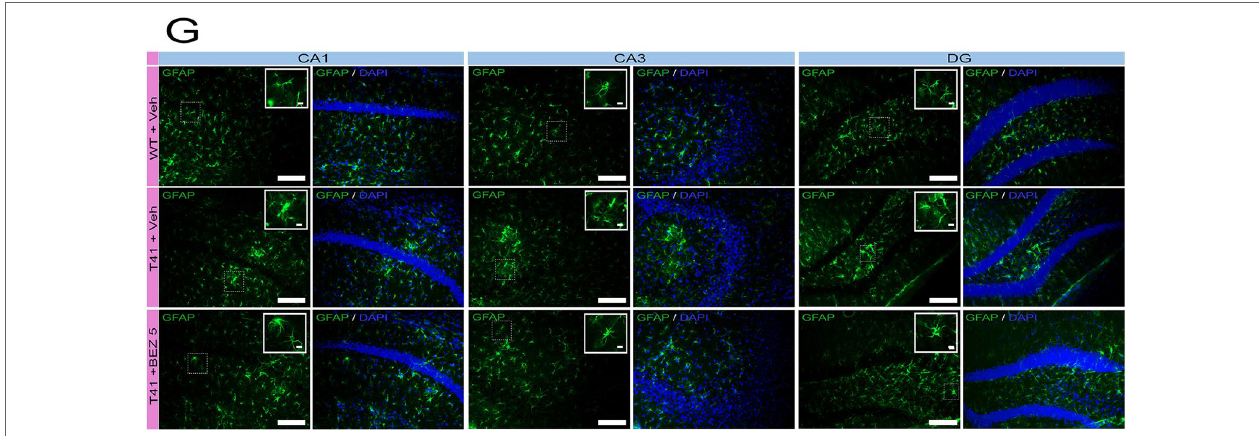
fIGURE 2 | Effects of BEZ treatment on Aβ, NeuN, and GFAP immunostaining. (A , B) Bar graphs represent the quantification of BEZ treatment effect on Aβ; (C , D) NeuN; (E – G) GFAP immunostaining. WT + Vehicle (n = 7), T41 + vehicle (n = 6), and T41 + BEZ 5 (n = 6). Representative images of Aβ (B) , NeuN (D) , and GFAP (G) immunostaining in CA1, CA3, and DG of animals. Inset images are a magnified portion to show detail (40× objective). *p < 0.05, **p < 0.01, and ***p < 0.001 (ANOVA followed by Newman-Keuls test). Scale bar for 20× objective = 125 µm. Scale bar for 40× objective = 10